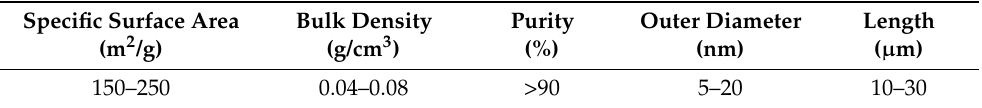
Table 1. Properties of multiwalled carbon nanotubes (MWCNTs). Specific Surface